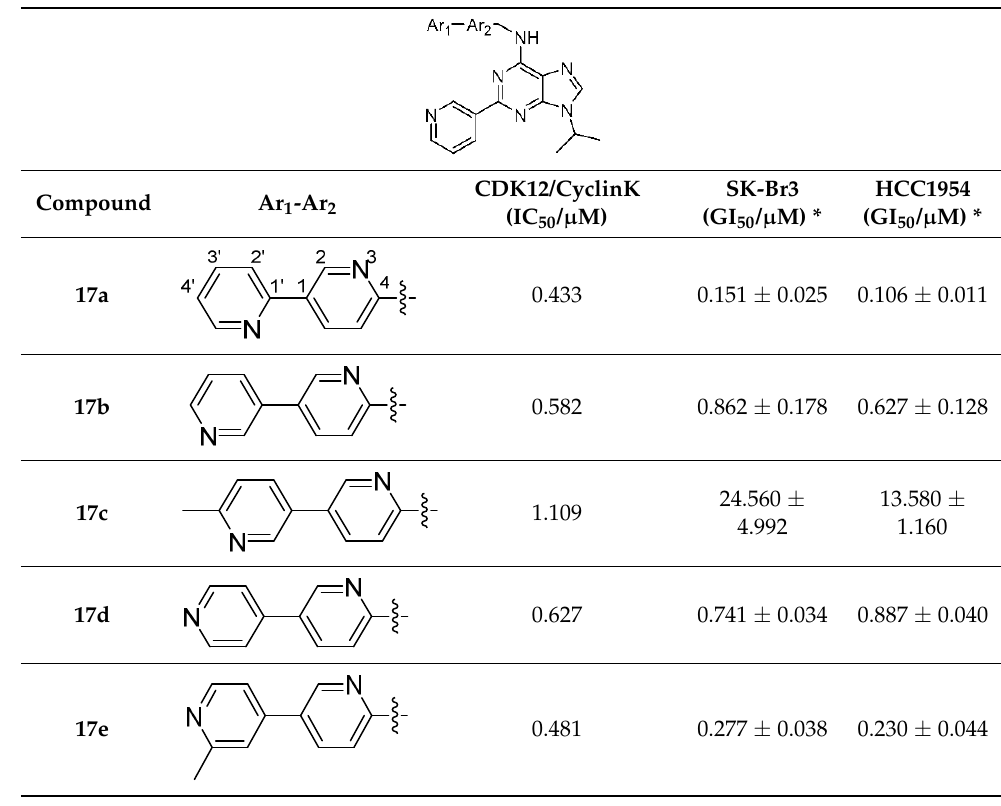
Table 1. Structure-activity relationship for the bi-pyridyl part at 6 position.